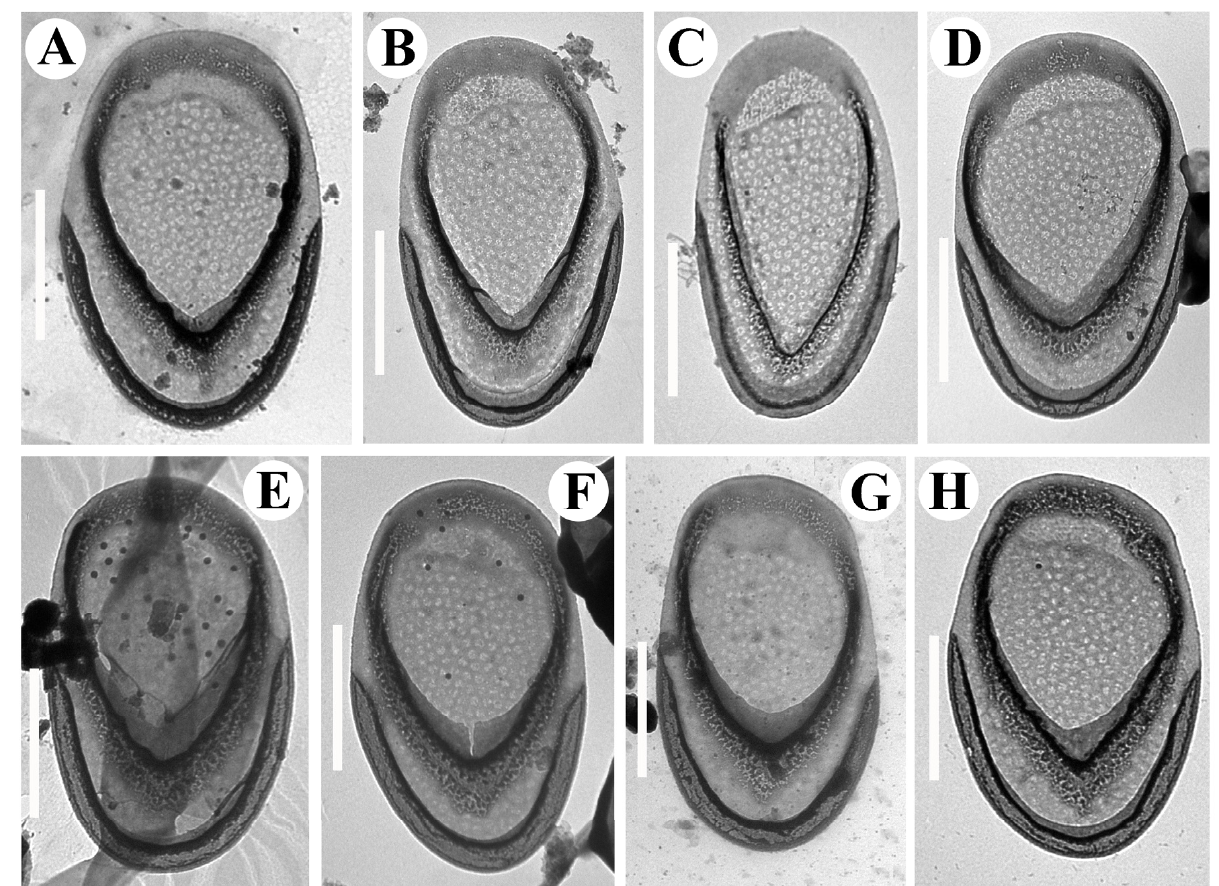
Figure 6. ( A – H ) Scales of Mallomonas preisigii , TEM. ( A – D ) Scales from site 6. ( E – H ) Scales from site 14. Note the presence of scattered papillae on some scales. ( E , F ) Scale bars: 2 µ